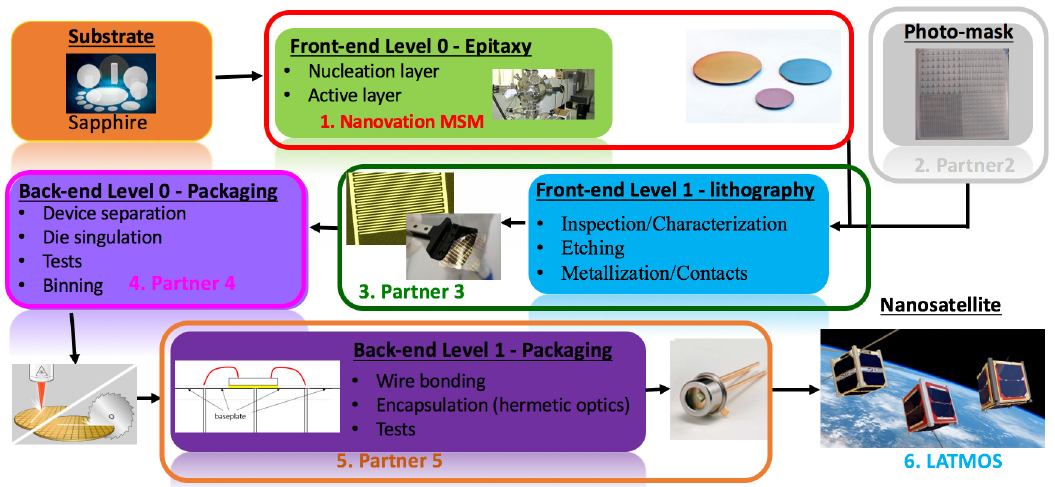
Figure 4. DEVINS manufacturing process. This action (collaborative project between LATMOS, Nanovation, and Observatoire de Versailles Saint-Quentin-en-Yvelines) is co-funded by the French Agence Nationale de La Recherche